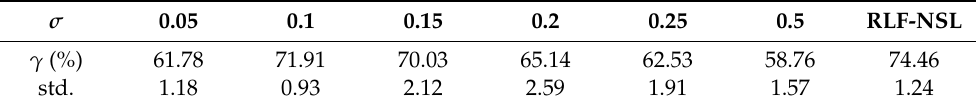
Table A6. The classification accuracy γ and the standard deviation(std.) on the IMDb for N = 1200 by the NSL with the Guassian and RLF kernels. For the Guassian kernel, we vary σ from 0.05 to 0.5. For the RLF-NSL, we take β =